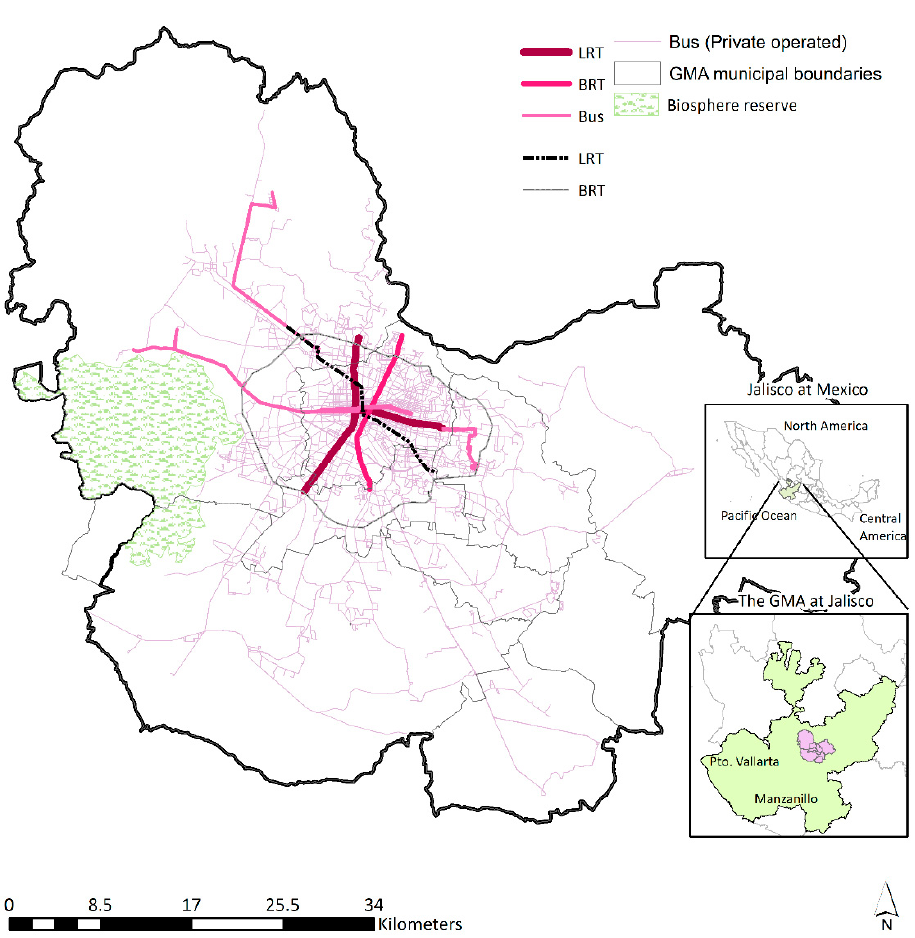
Figure 3. Mass Public Transport System in the Guadalajara Metropolitan Area. Source: Authors based on [42,43,45–50]. Table 1. Characteristics of Modes in the SITEUR.